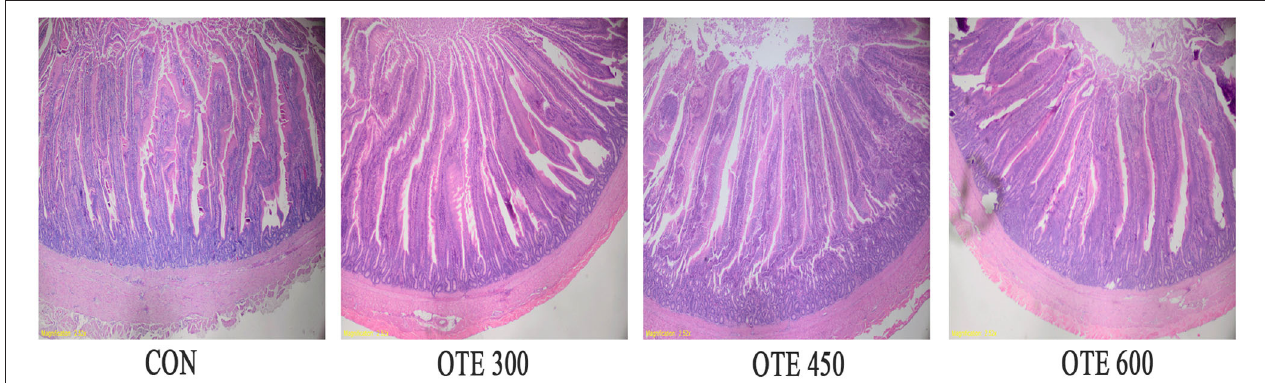
FIGURE 1 | Effects of organic trace elements supplementation on duodenal morphology of late-phase laying hens. Representative images ( × 40) were stained with hematoxylin and eosin (H and E). Con represents control group, and OTE300, OTE450, and OTE600 represent the 300, and 600 mg/kg organic trace elements groups,